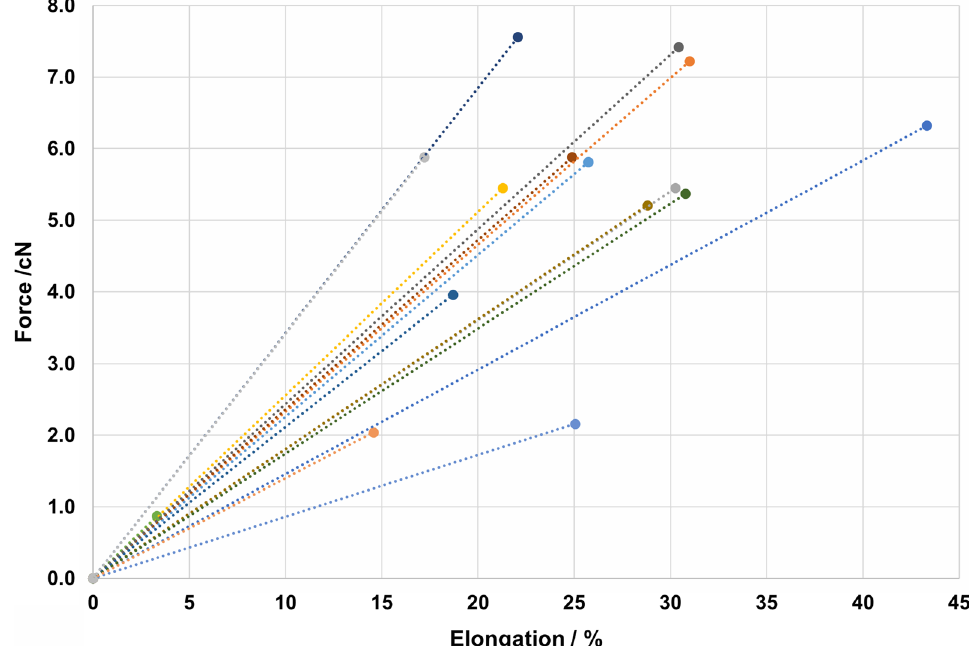
Fig. 1 The force elongation curve of 15 randomly selected fibers from DPL 1612B2XF cotton grown in 2018